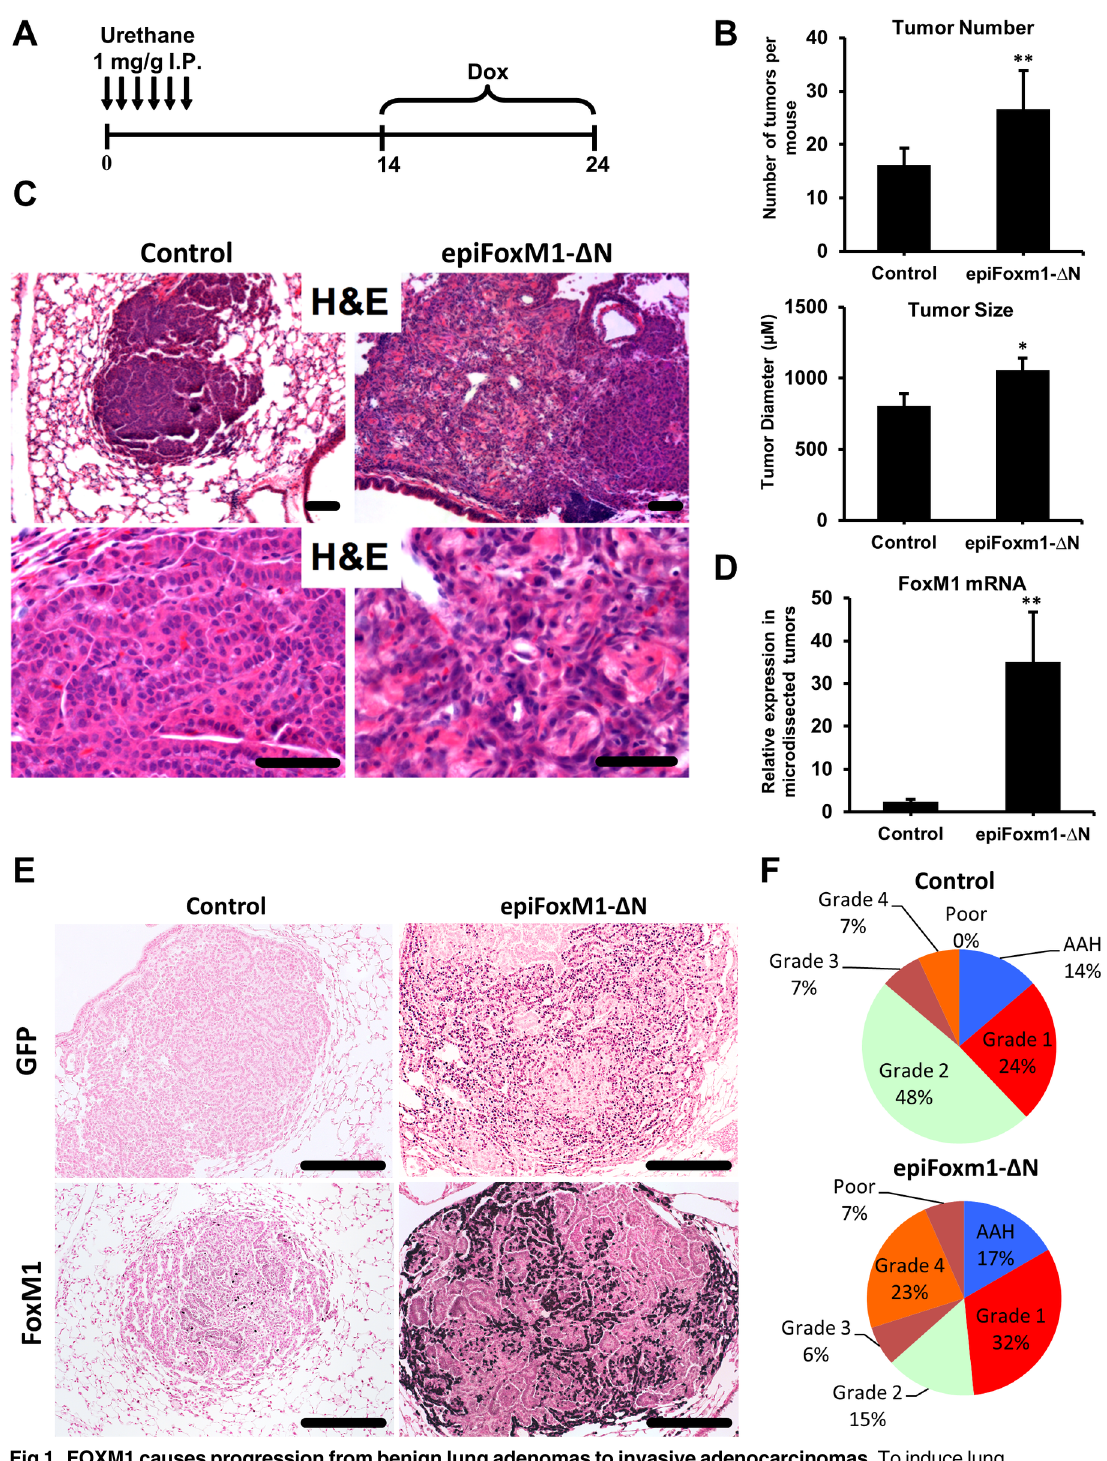
Fig 1. FOXM1 causesprogression from benign lung adenomas to invasive adenocarcinomas. To induce lung adenomas, the Spc-rtTA/tetO-GFP-FoxM1- Δ N doubletransgenic ( epiFoxM1- Δ N , n = 9) and control singletransgenic(n = 6) mice were treated with six IP injectionsof urethane.At 14 weeks after the first urethaneinjection, when early low-gradelung adenomas were alreadypresent, epiFoxM1- Δ N mice were treated with Dox to induce FOXM1- Δ N transgene in SP-C- expressingtumor cells and epithelialtype II cells. Mouse lungs were harvested at 24 weeks after the first urethaneinjection. (A) . Schematic of lung tumor inductionand FoxM1- Δ N expression. (B) Average number (top) and size (bottom) of lung